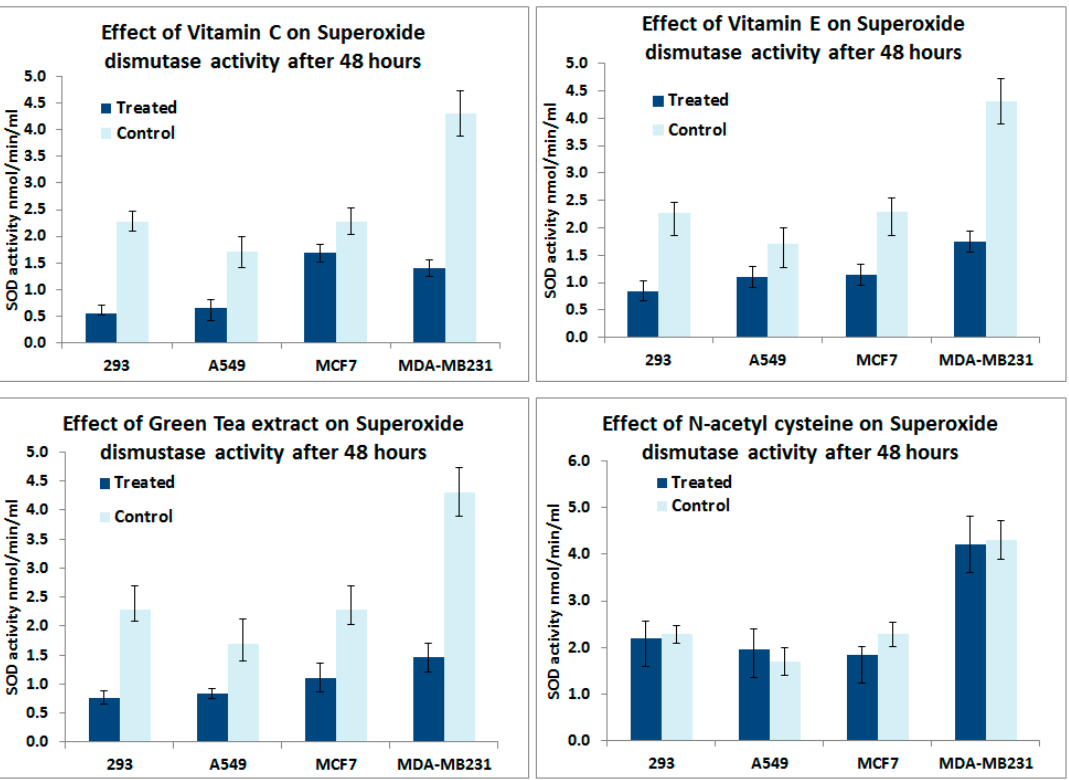
Figure 5. In vitro analyses on the effect of antioxidant supplements for 48 h on Superoxide dismutase activity in 293, MCF-7, MDA-MB231 and A549 lung cancer cells.